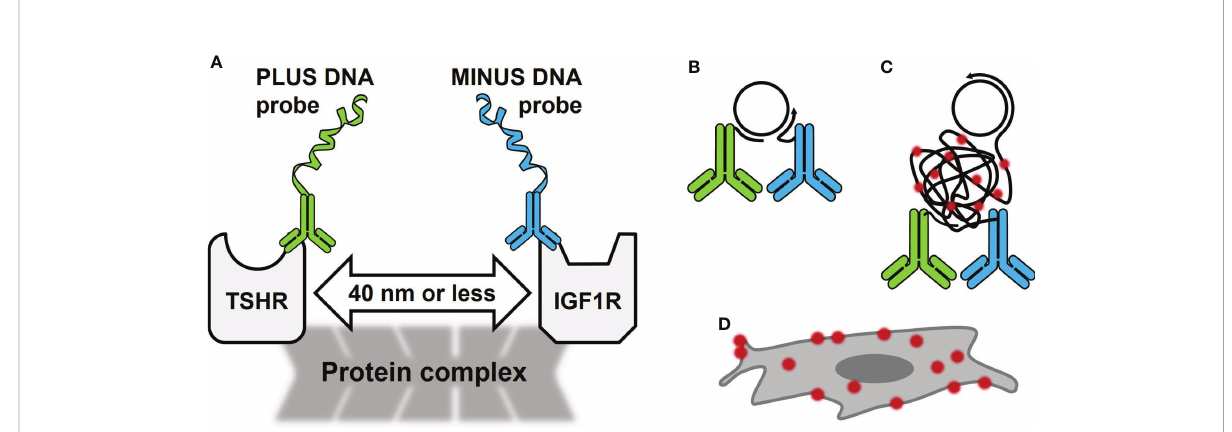
FIGURE 1 Schematic of Proximity Ligation Assay (PLA) in the TSHR/IGF1R Signalosome. (A) PLA oligonucleotides PLUS and MINUS are directly conjugated to primary antibodies for TSHR and IGF1R, respectively. These antibodies bind to the receptors ’ extracellular regions on fi xed cells. In a signalosome, the receptors were shown to be within 40 nm of each other. (B) PLUS and MINUS DNA probes will ligate and create a DNA circle that becomes a template for rolling circle ampli fi cation. (C) During ampli fi cation, fl uorescently tagged oligonucleotides bind DNA. (D) PLA signals look like bright dots on the cell